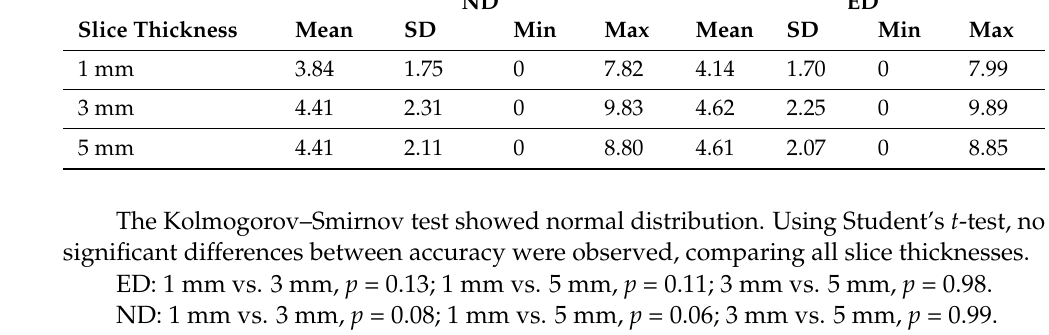
Table 2. Normal distance and euclidean distance under guidance with the PCS. ND ED Slice Thickness Mean SD